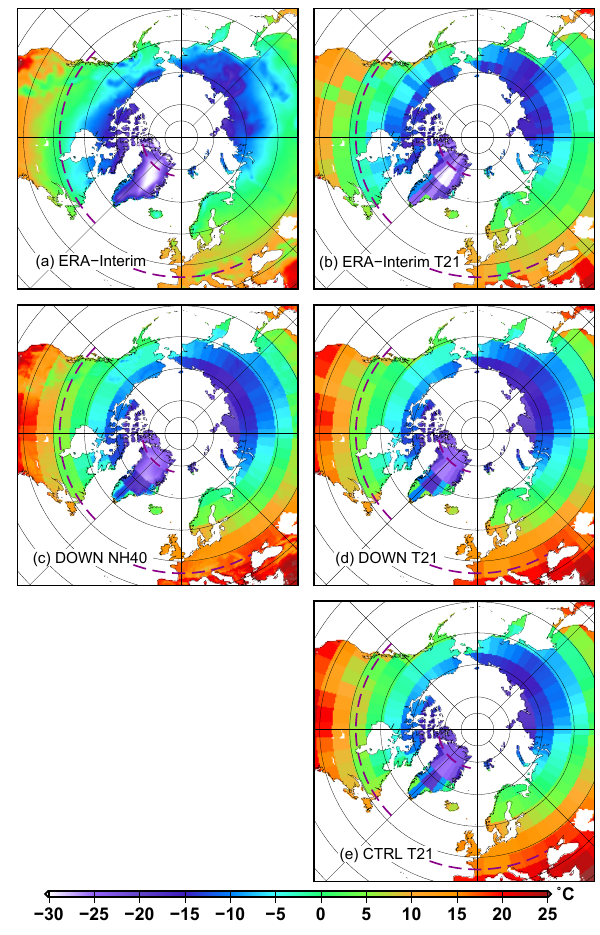
Figure 3. Northern Hemisphere annual mean surface temperature ( ◦ C) in: ERA-Interim (a, b) , the i LOVECLIM that includes a down- scaling ( c, d ; with z q = 2000m, α min q = 0 . 8 and f s = 0 . 6) and the standard version of i LOVECLIM ( e , CTRL). The left panel corre- sponds to data on the high-resolution grid, whilst on the right data are aggregated to the T21 resolution. The dashed purple lines iden- tify the selected transects used for